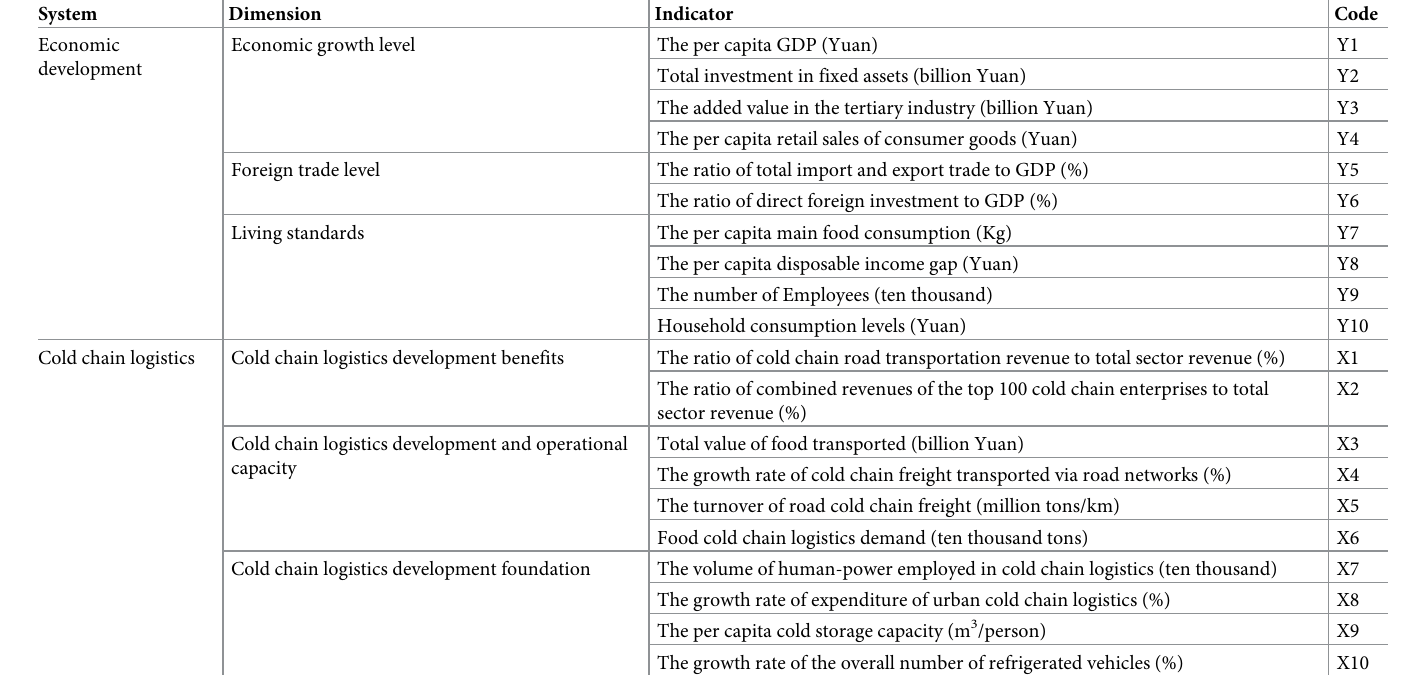
Table 1. Evaluation index system for cold chain logistics and economic